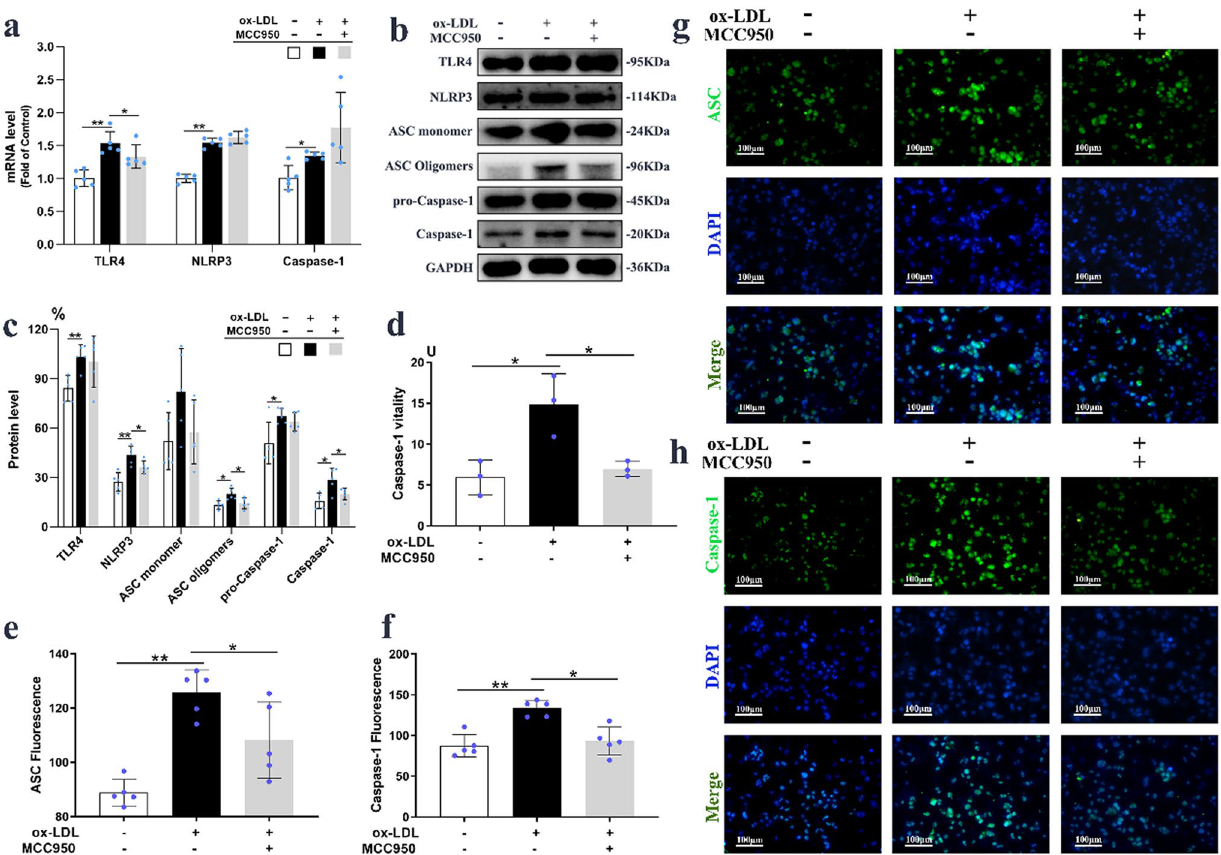
Figure 5. MCC950 inhibited ox-LDL induced NLRP3 inflammasome activation in macrophages. The mRNA and protein (n = 5/group) expressions of TLR4, ASC, NLRP3, Caspase-1 in ox-LDL induced macrophages were shown on ( a – c ). The vitality of Caspase-1 was measured and presented on ( d ). The representative images and quantitation of ASC and Caspase-1 by immunofluorence staining (n = 5/group) were exhibited on ( e – h ). GAPDH served as an internal control. The magnification was ×200, Scale bar = 100 μm. Data were presented as mean ± SD. * P < 0.05 was considered significant, ** P <